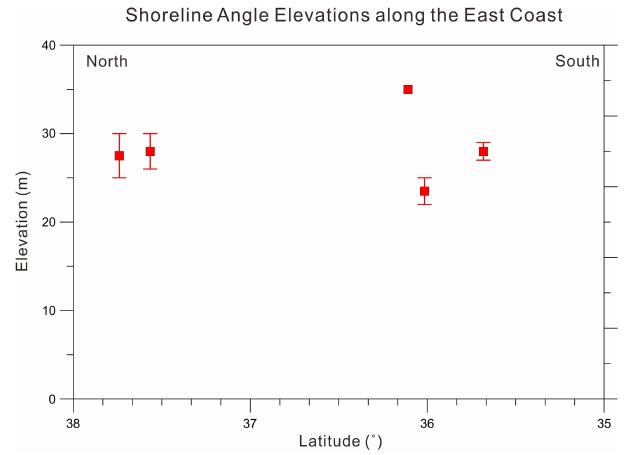
Figure 14. LIG relative sea level of the shoreline angles with re- spect to latitude along the east coast of Korea. See Table 2 for more